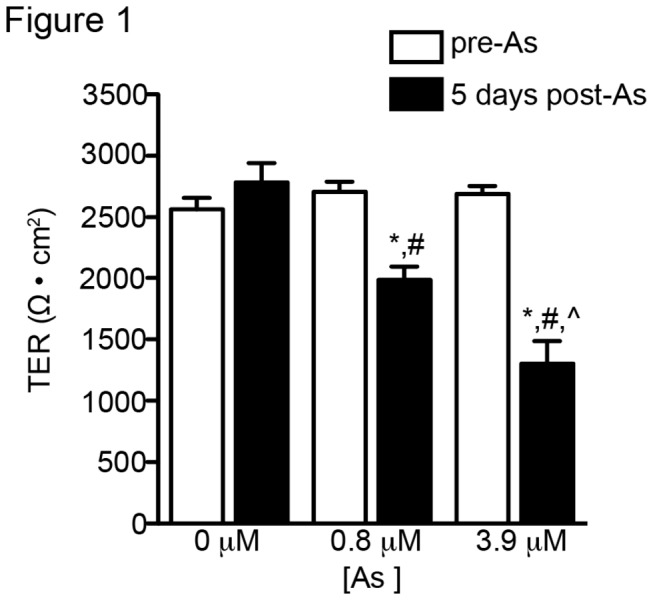
Arsenic reduces barrier function in primary mouse tracheal epithelial (MTE) cell cultures.MTE monolayers with established transepithelial resistance (TER) were exposed to arsenic-free or arsenic-supplemented media for 5 days. A dose-dependent reduction in TER was observed after a 5-day exposure to arsenic. “*” indicates significant difference from arsenic-free cultures on day 5 post-arsenic exposure, “^” indicates significant difference from the 0.8 μM cultures on day 5 post-arsenic exposure, and “#” indicates a significant difference (P < 0.05) in TER between day zero and day 5 post-arsenic exposure for each treatment group.